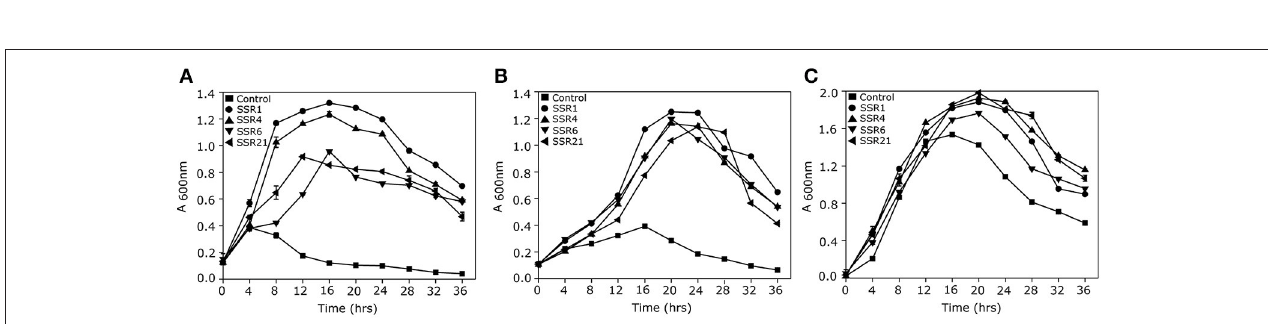
FIGURE 3 | Complementation of osmotolerance property of salt stress tolerant clones. Growth of E. coli (MKH13) metagenomic clones harboring pSSR1 (•), pSSR4 ( N ), pSSR6 ( H ), pSSR21 ( ◭ ), and E. coli (MKH13) host strain carrying empty plasmid vector ( (cid:4) ) in (A) LB broth supplemented with 3.0% NaCl(w/v), (B) LB broth supplemented with 3.7% KCl, (C) LB